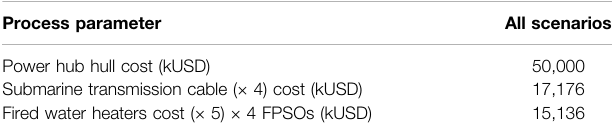
TABLE3| Costsofpowerhubhull,submarinetransmissioncablesand fi redwater heaters in the FPSOs. Process